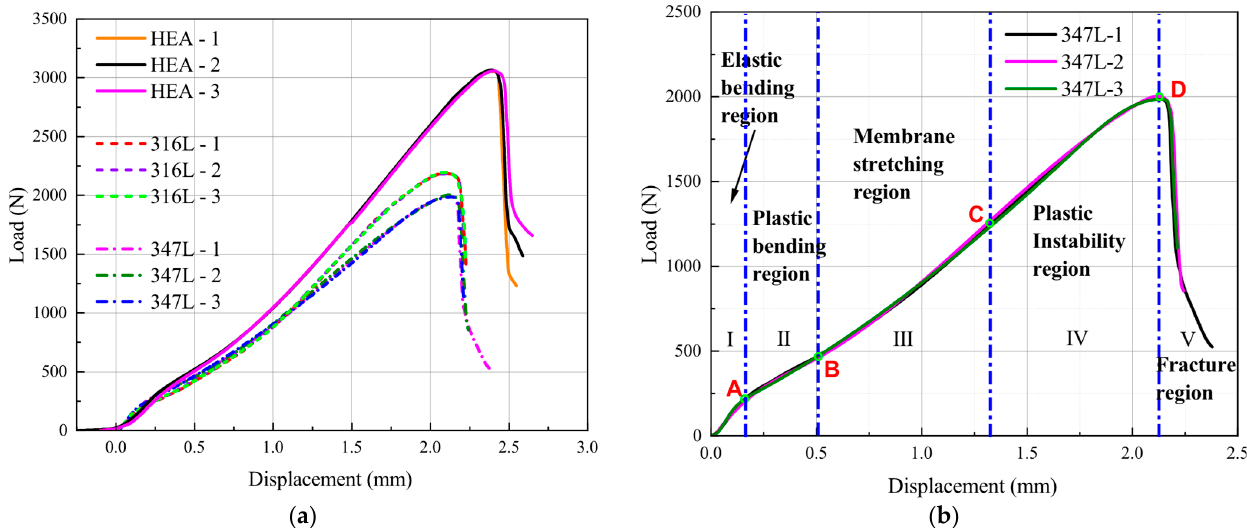
Figure 7. Force–displacement curve of SPT. ( a ) The three materials; ( b ) representation of the different stages.